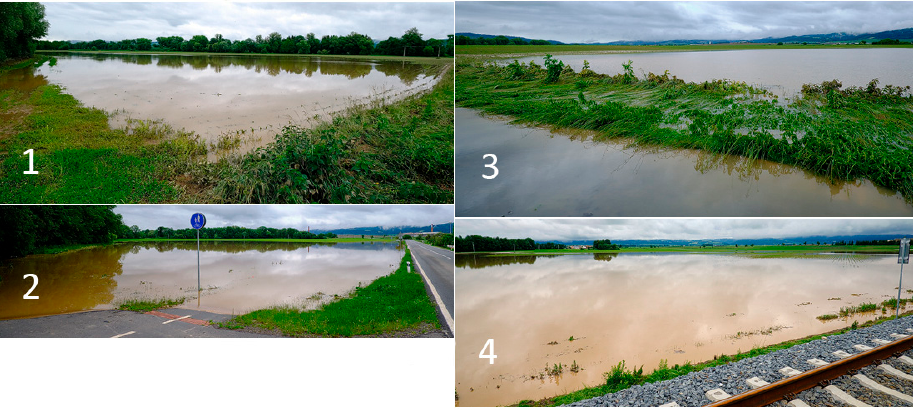
Figure 12. Photo documentation of four temporary lagoons near Uni č ov city from 8 June 2020. The location of each lagoon is shown in Figure 13, and given by its number.